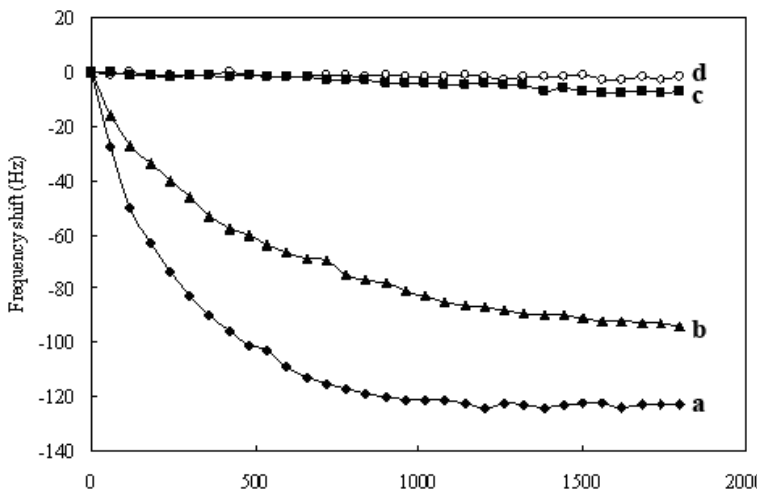
Figure 7. Typical characteristics of frequency shift that correspond to (a) the black line and solid diamond, the detection procedure of PCR products of 1.3×10 7 CFU/mL S. epidermidis ATCC 12228 with 0.6 mg/mL Au nanoparticles amplification; (b) the black line and solid triangle, the detection procedure of PCR products of 1.3×10 7 CFU/mL S. epidermidis ATCC 12228 without Au nanoparticles amplification; (c) the black line and solid squares, the detection procedure of blank control; (d) the black line and circles, the detection procedure of negative